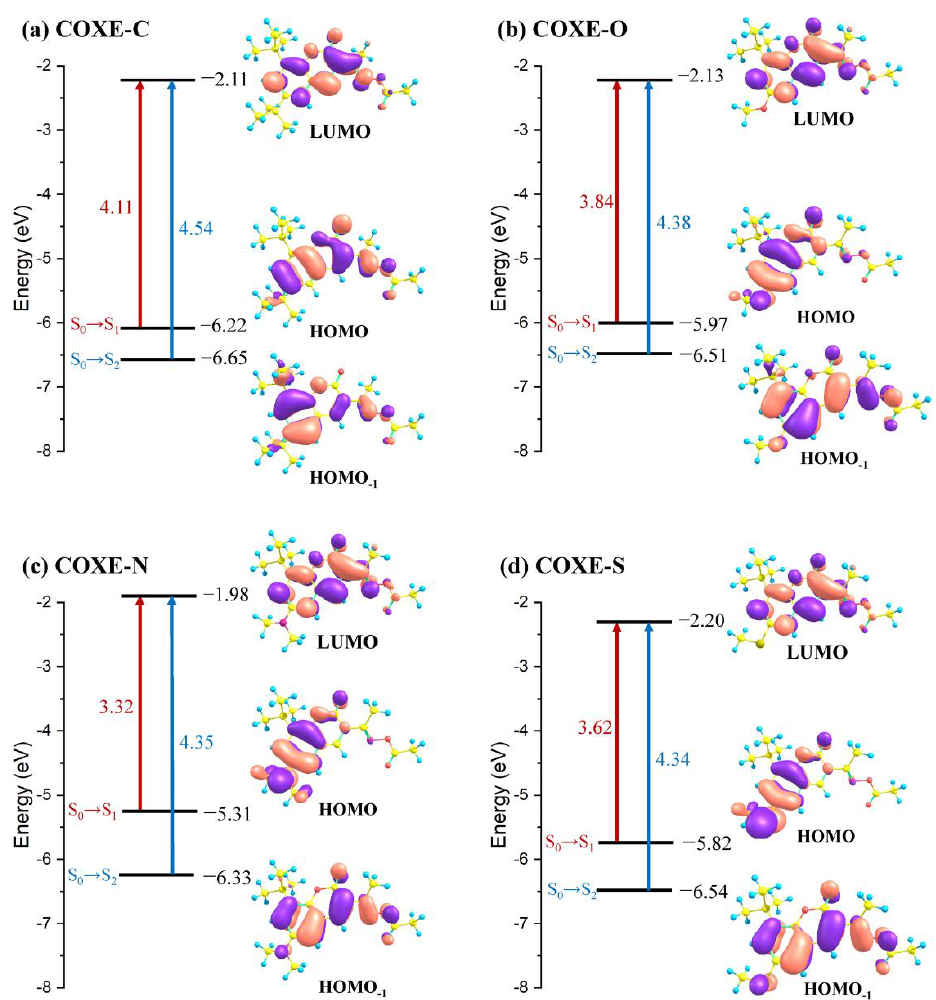
Figure 4. The frontier molecular orbitals and the energy gap (HOMO − LUMO) for ( a ) COXE-C, ( b ) COXE-O, ( c ) COXE-N and ( d ) COXE-S were calculated at the TD/B3LYP/6-31G(d)